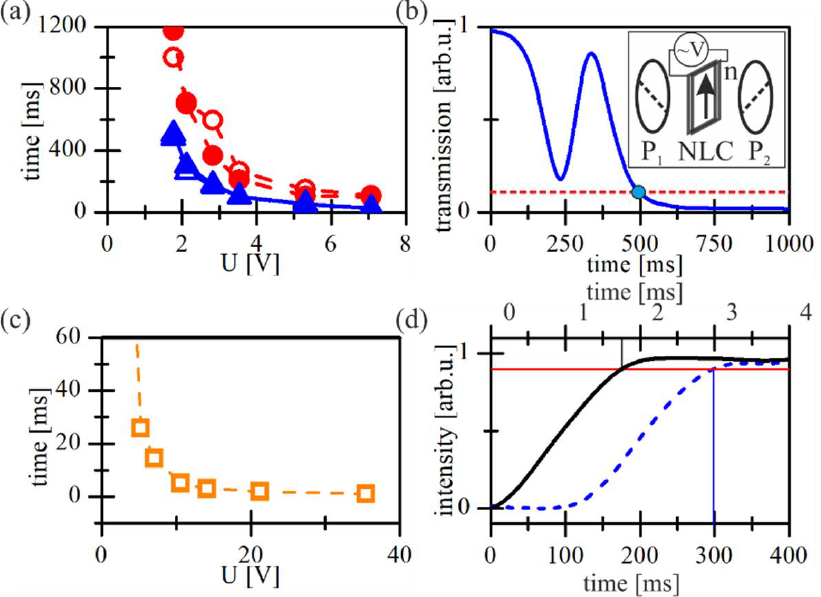
Figure 5. Experimental results on waveguide formation times and reorientation times. ( a ) Formation times as a function of voltage for 5 μm (red circles) and 10 μm (blue triangles) electrode widths. Open and filled markers refer to cells without and with an additional alignment layer, respectively. ( b ) Transmission through NLC cell vs. determined in the cross-polarizer configuration plotted for U = 2.1 V. The dotted red line denotes a decrease in the transmitted beam intensity to 10% of the maximum value. ( c ) Reorientation time as a function of a biasing voltage (orange squares). ( d ) Comparison of waveguide formation times for biasing voltage U = 2.1 V with (solid black line) and without 21.2 V overdriving voltage (dotted blue line). Intensity represents voltage rise time on the